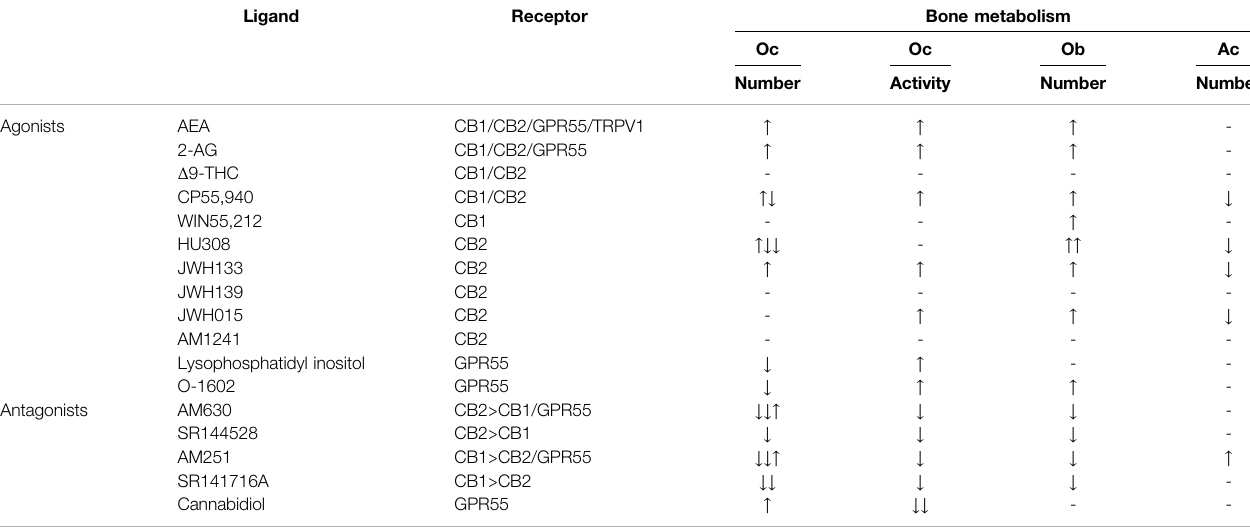
TABLE 1 | The role of cannabinoid receptor ligands in regulating osteoclasts, osteoblasts, and adipocytes in vitro and in vivo .